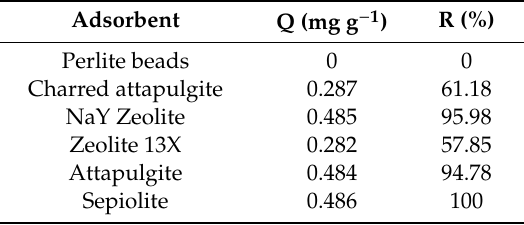
Table 1. Screening of the selected adsorbents for the [bpy] Cl elimination.